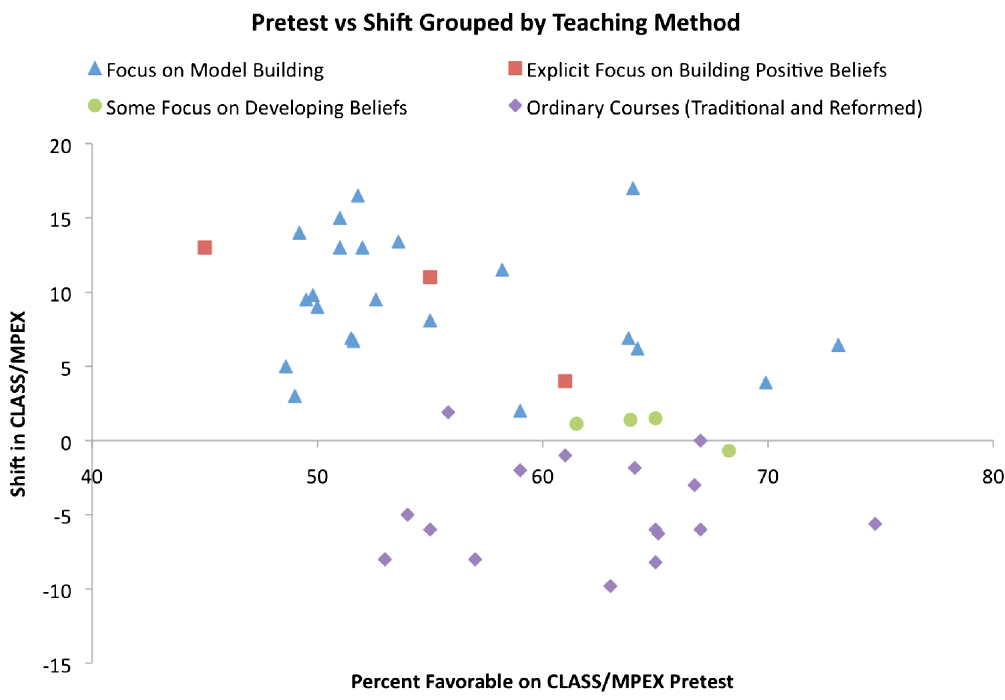
FIG. 5. Pretest percent expertlike scores versus shifts on CLASS and MPEX with data points grouped by teaching